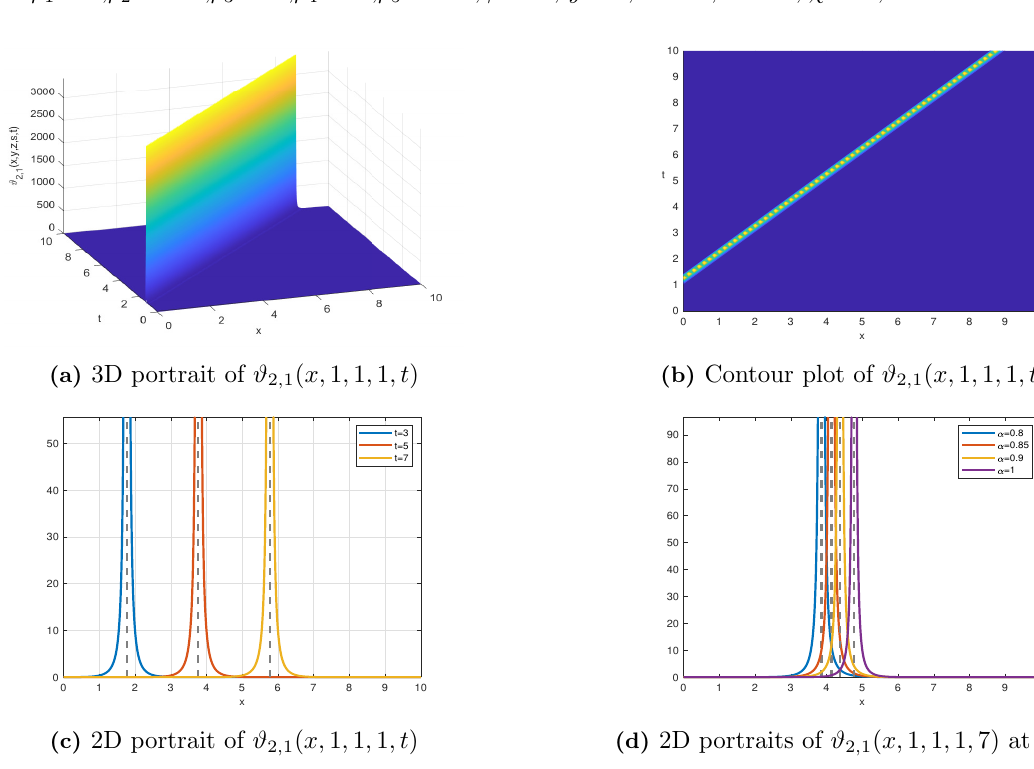
Figure 1. The dark soliton portraits of ϑ 1 , 1 ( x, 1 , 1 , 1 , t ) in Eq. (19) for the parameters ρ 1 = 3 ,ρ 2 = − 1 ,ρ 3 = 3 ,ρ 4 = 2 ,ρ 5 = − 3 ,γ = 0 . 5 , y = 1 , z = 1 , s = 1 , χ = 5 , and α = 0 . 8.